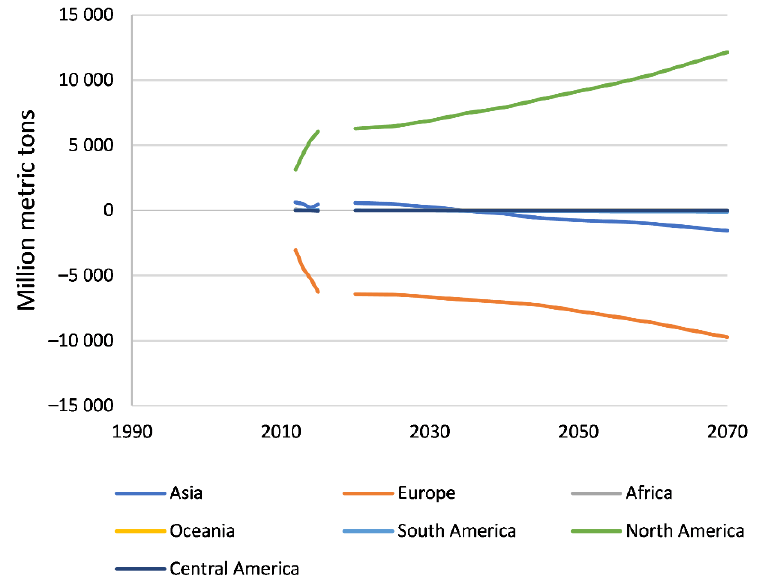
Figure 10. Global net exports of wood pellets, by region, for SSP2, 2012 to 2015 historic, 2020 to 2070 projections from FOROM.